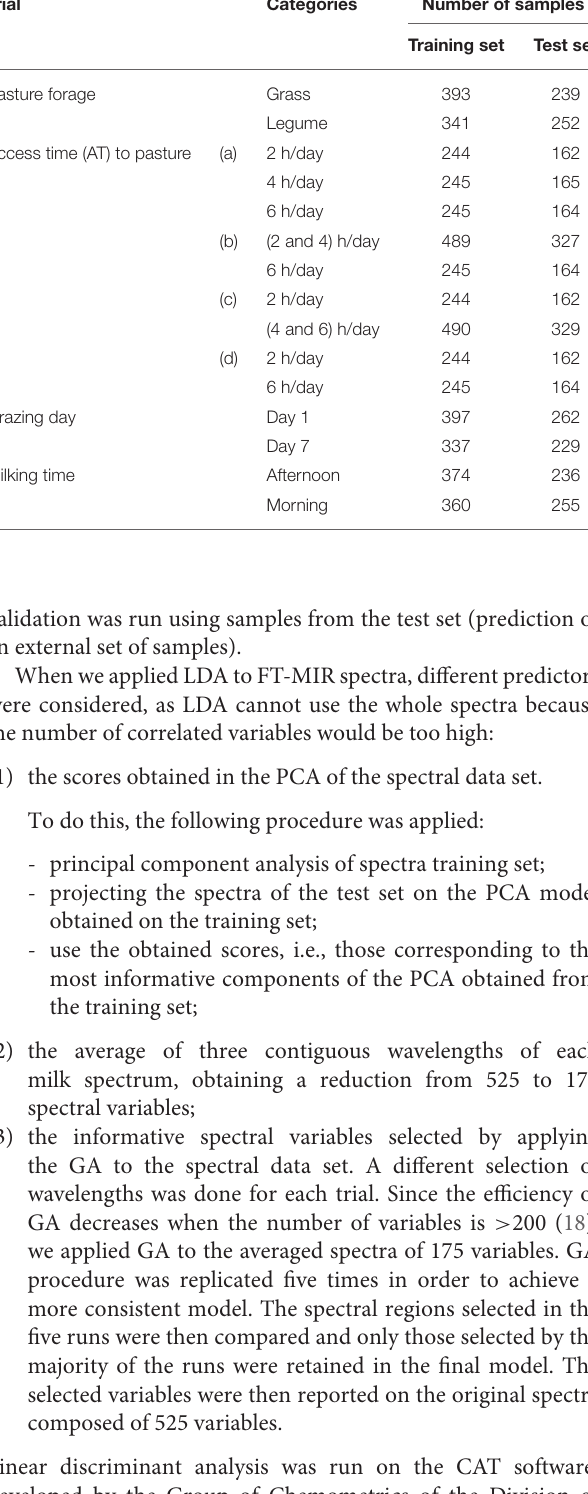
TABLE 2 | Trials and sample subdivision into training and test sets.